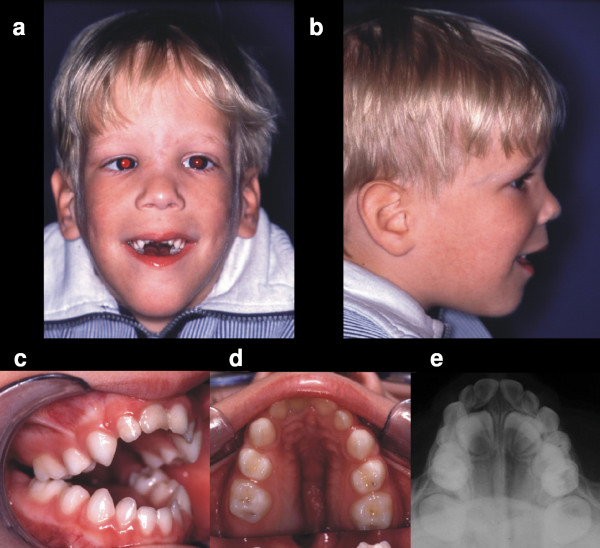
a-e Facial appearance (a, b), circular open bite (c) and palatal aspect (d) of a postnatally orotracheally intubated preterm infant in the initial phase of the dentition. Notice that the teeth of the child are 'in occlusion' on Figures a-c. The food intake – limited to soft or mashed foods due to the extreme dysgnathia – leads to marked frustration. The infant is teased because of its eating problems and the shape of its jaw and head. Radiography revealed premature ossification of the median suture (e).